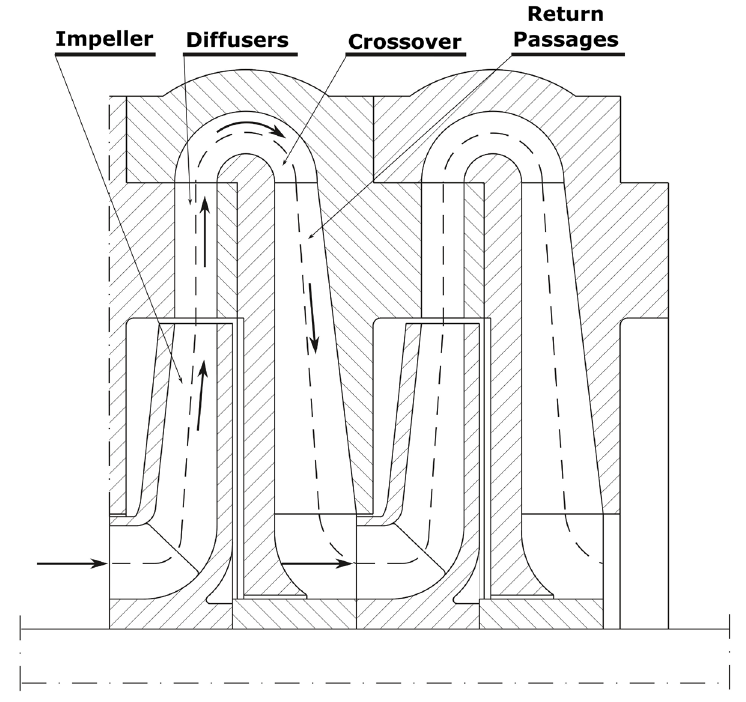
Figure 3. Elements of a multistage pump stator [3].